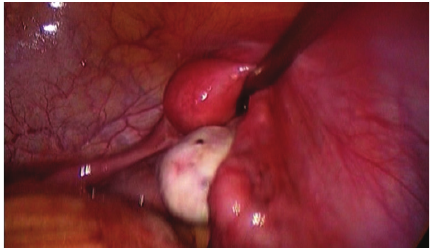
Figure 2: Rudimentary uterus on the